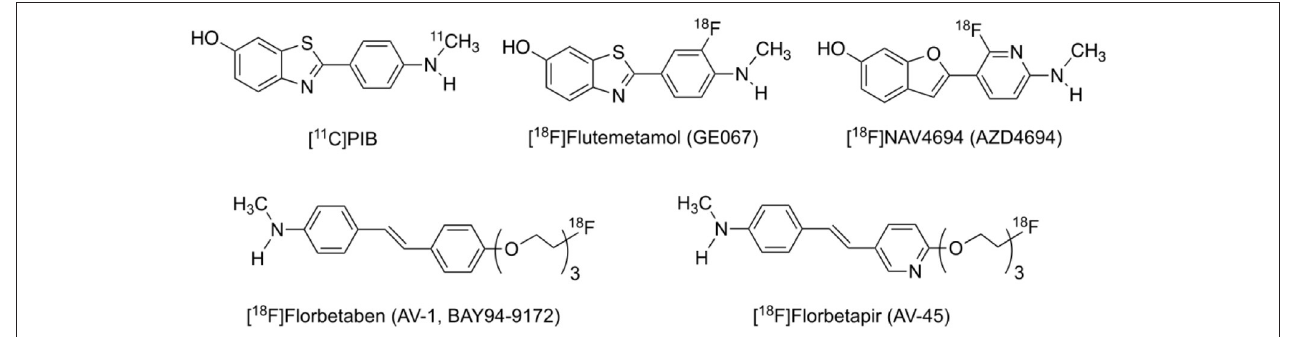
FIGURE 1 | Structures of representative PET radiotracers for A β